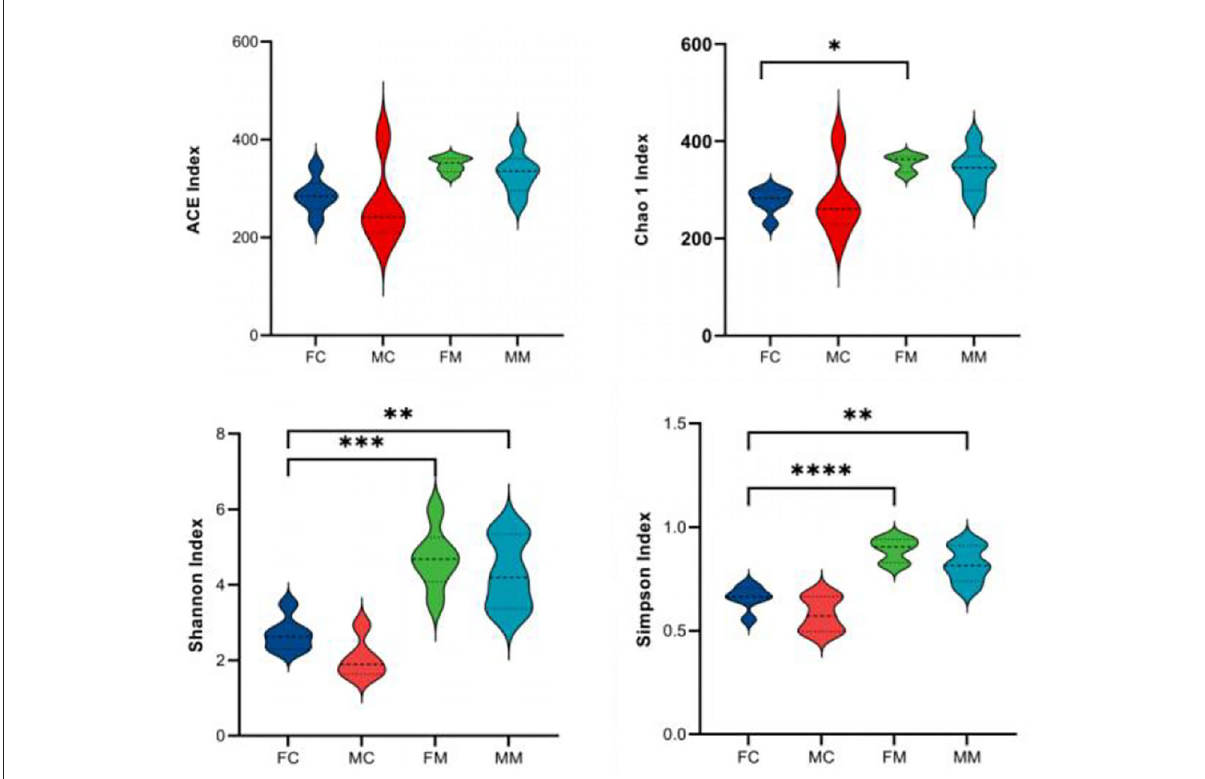
FIGURE2 The α diversity index was calculated based on the OTU classification level, consisting of ACE, Chao 1, Shannon, and Simpson. * p < 0.05, ** p < 0.01, *** p < 0.001, **** p <